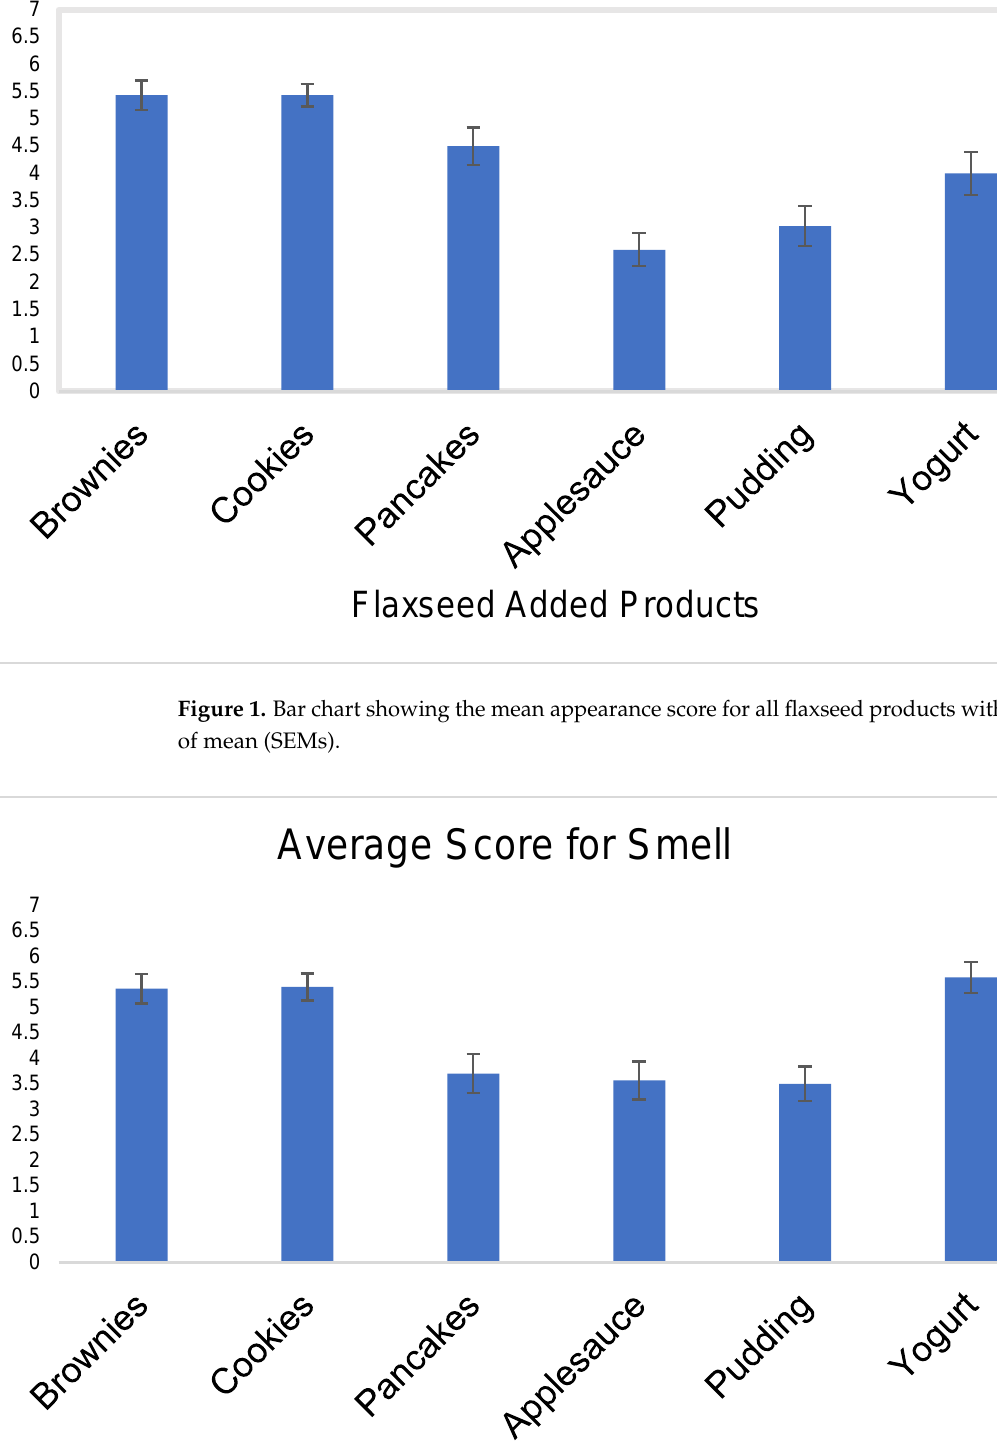
Figure 2. Bar chart of the mean score with SEM for smell for all flaxseed products. •